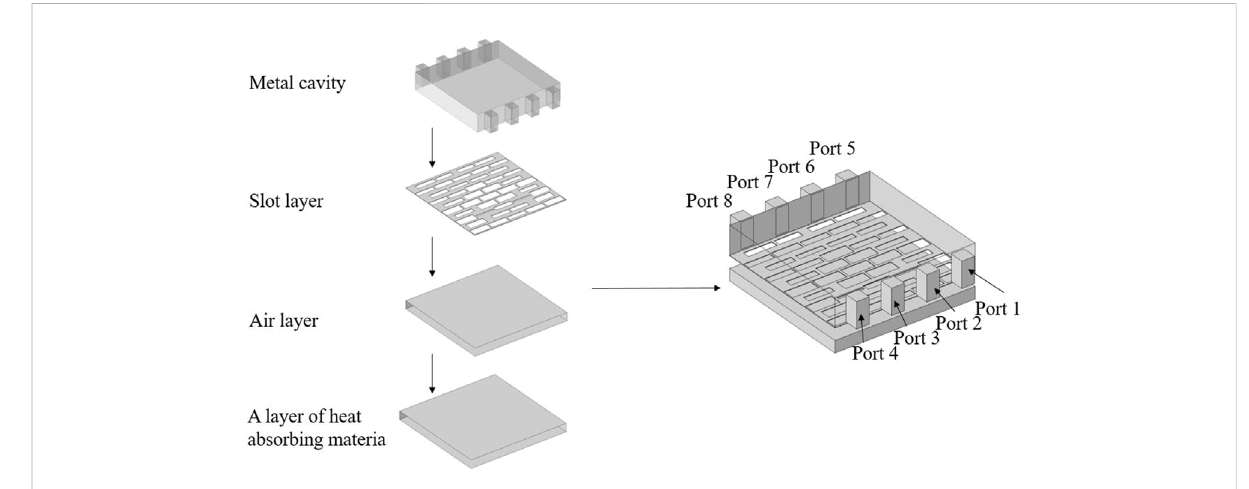
FIGURE 1 Model geometry.